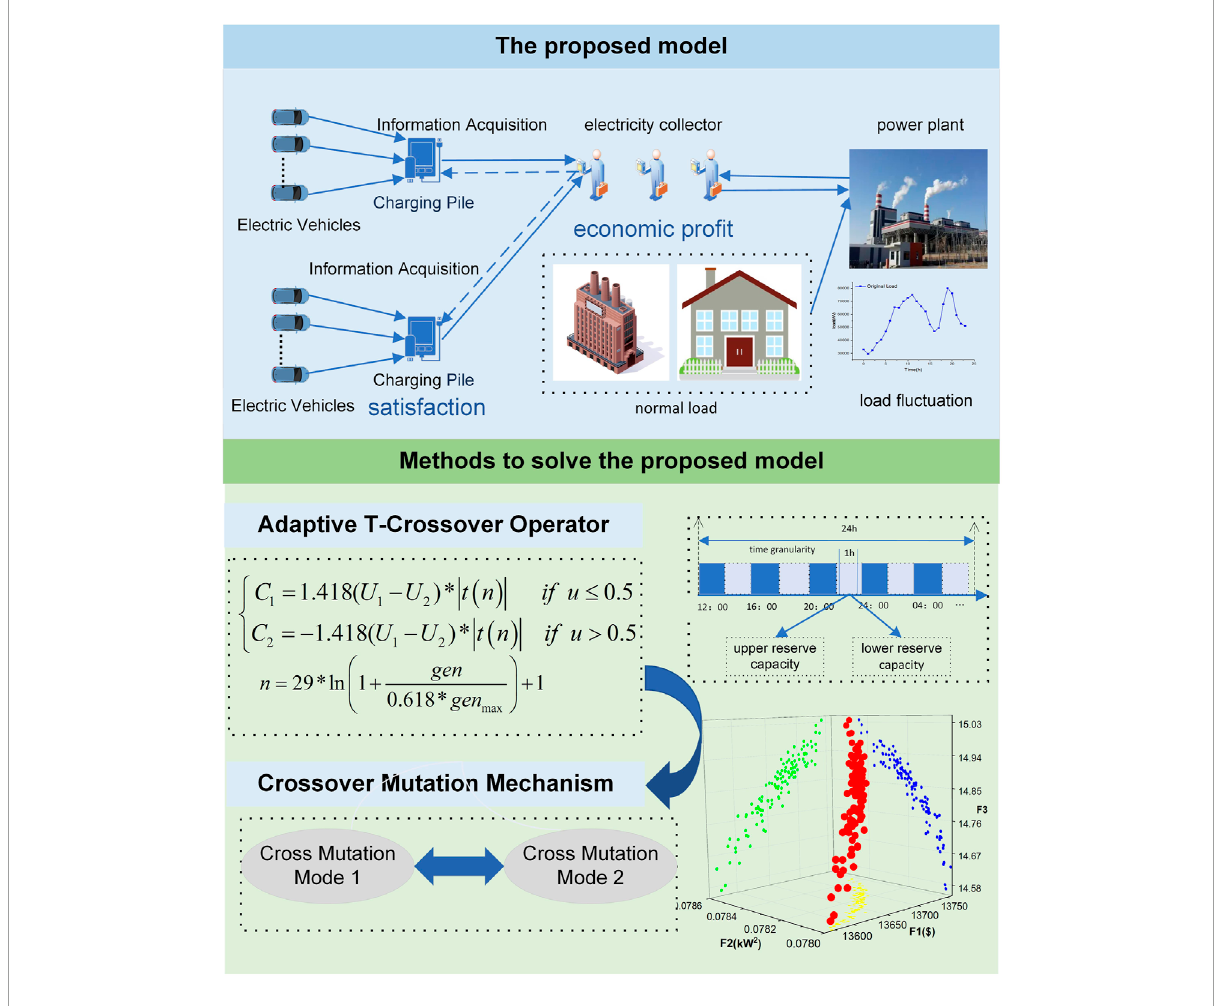
FIGURE 2 Overall framework of the proposed model and improved method.